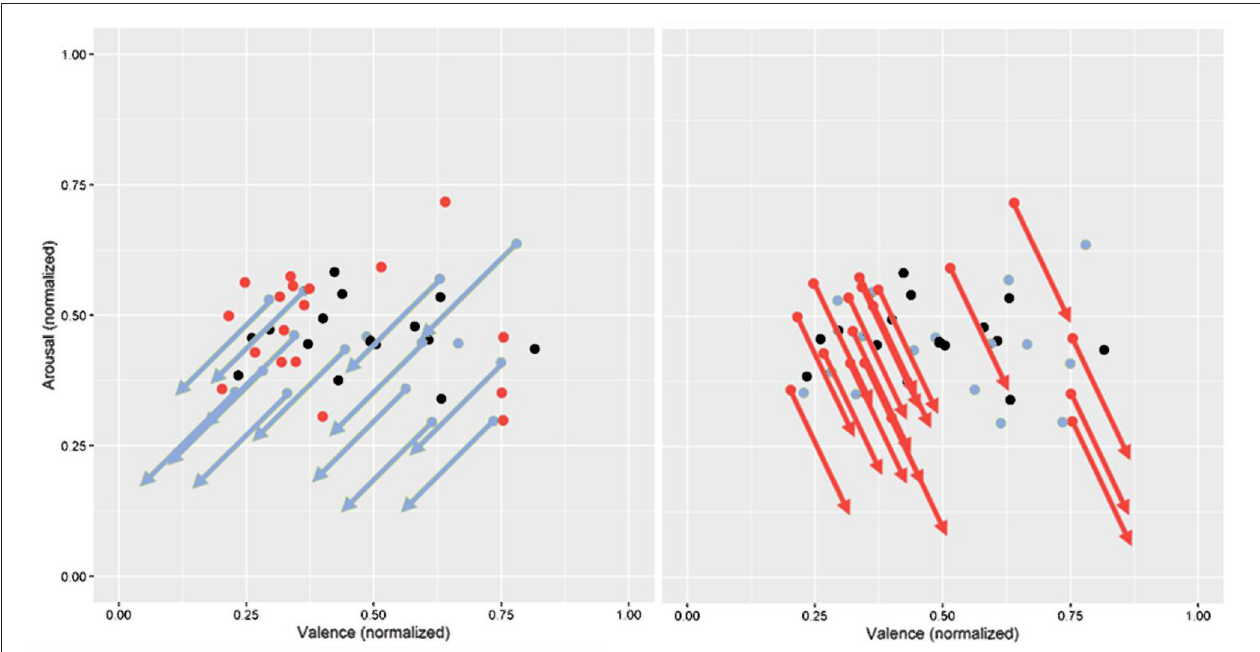
FIGURE 11 | Application of the adaptation directions to the identified clusters (ARC 1: blue dots and arrows, ARC 3: red dots and arrows).